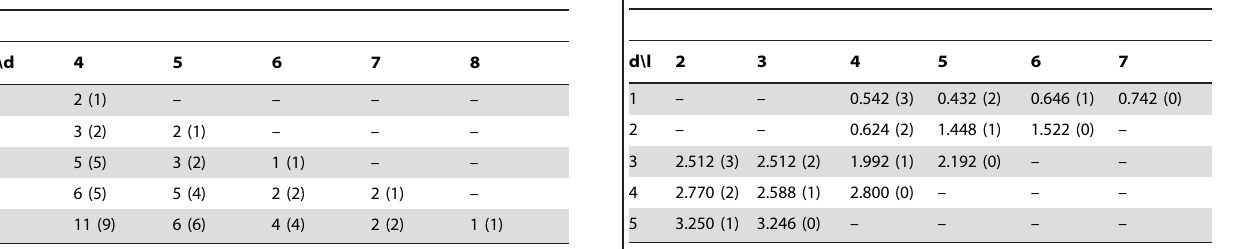
Table 5. Data with GC